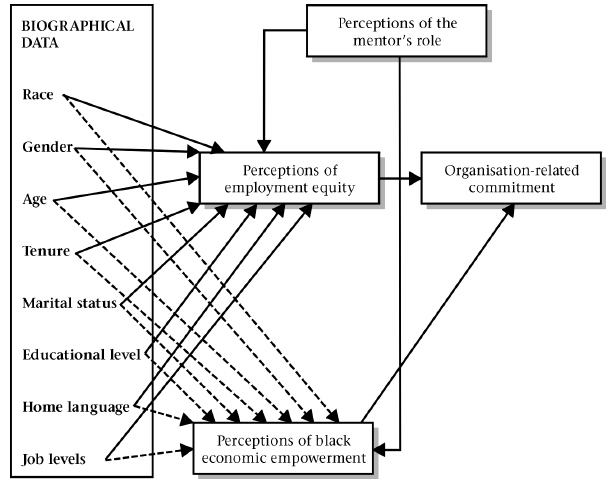
Figure 1: Predictive model of employee commitment [Adapted from Guest (1995); Innes (2002); Iverson (1996); Lau and Woodman (1995); Müller and Roodt (1998); Republic of South Africa (55 of 1998); Roodt et al. (1993) and Storm and Roodt